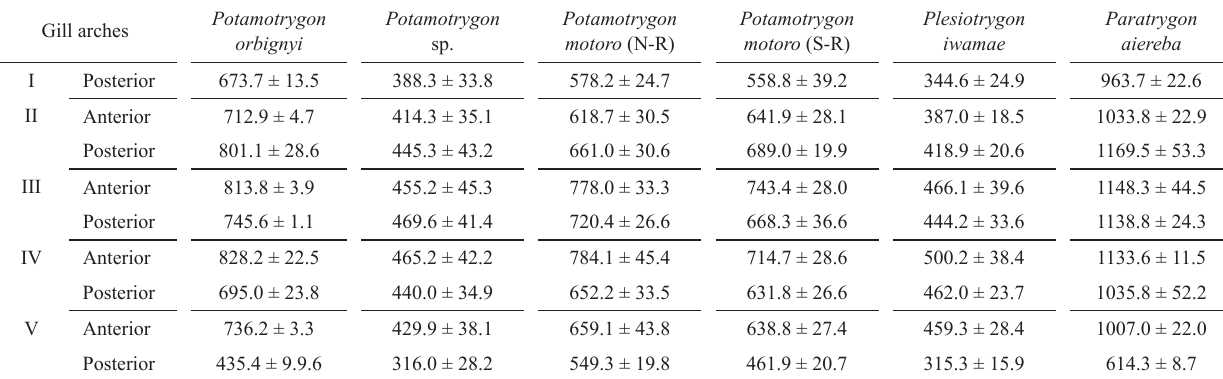
Table 4. Total filament lengths (mm) (mean ± S.E) of different gill arches among near-term potamotrygonid embryos. Potamotrygon Potamotrygon Gill arches orbignyi